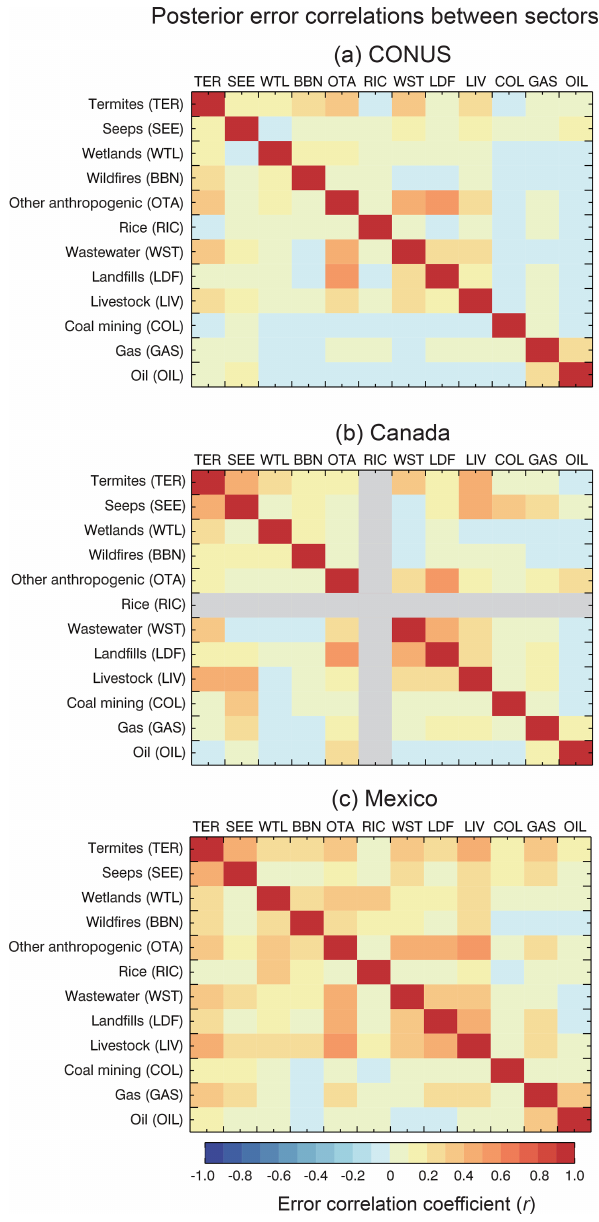
Figure 6. Posterior error correlation coefficients ( r ) between sec- toral methane emissions in the contiguous US (CONUS), Canada, and Mexico+ using the sector-aggregated error covariance matrix as described in Sect. 2.6. Error correlation coefficients indicate the ability of the inversion to separate emissions between sectors (0: perfectly, ± 1: not at all). Results are from the base inversion for the year 2015. Results for other years show similar patterns.